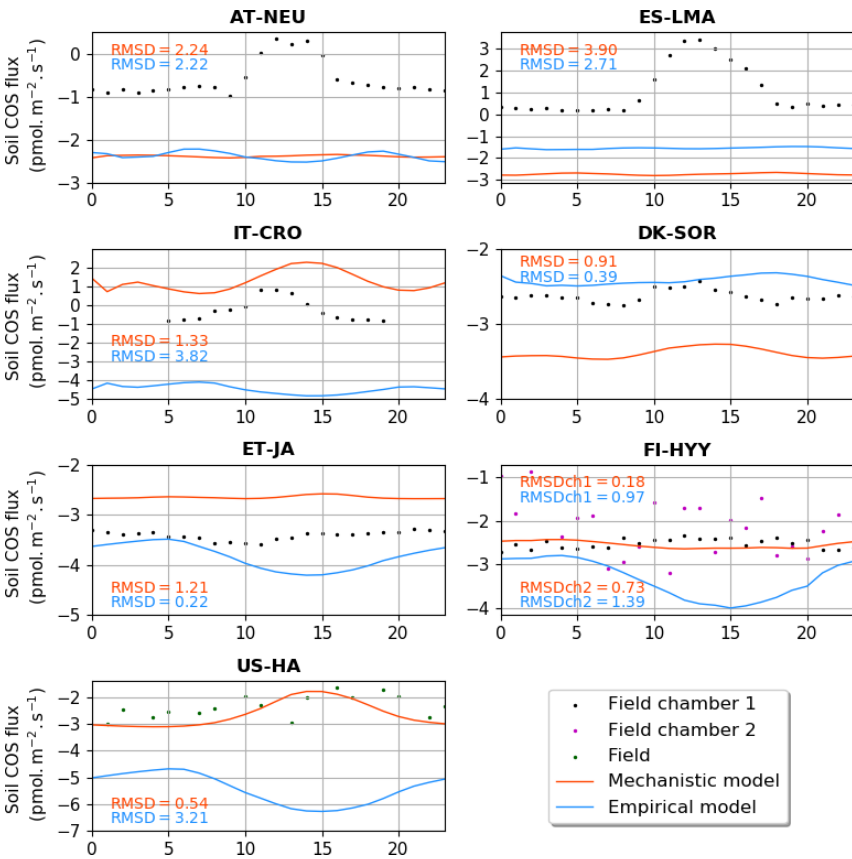
Figure 3. Mean diel cycle of net soil COS fluxes (pmolm − 2 s − 1 ) over a month at AT-NEU (August 2015), ES-LMA (May 2016), IT-CRO (July 2017), DK-SOR (June 2016), ET-JA (August 2016), FI-HYY (August 2015), and US-HA (July 2012). Soil COS fluxes are computed with a variable atmospheric COS concentration. The observation-based diel cycles (dots) are computed using random forest models at AT- NEU, ES-LMA, IT-CRO, DK-SOR and ET-JA. At AT-NEU and ES-LMA, RMSD values between the simulated and observed fluxes are given with the respective model colour at each site and for both soil chambers at FI-HYY (ch1 and